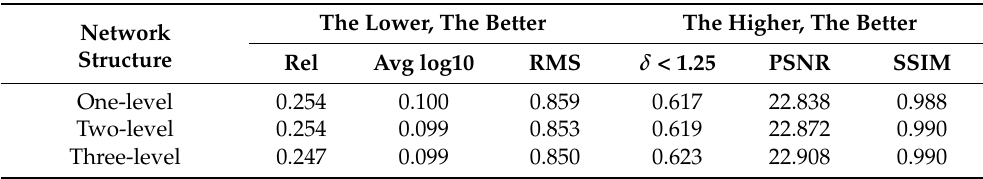
Table 2. Comparison of the different network structures.